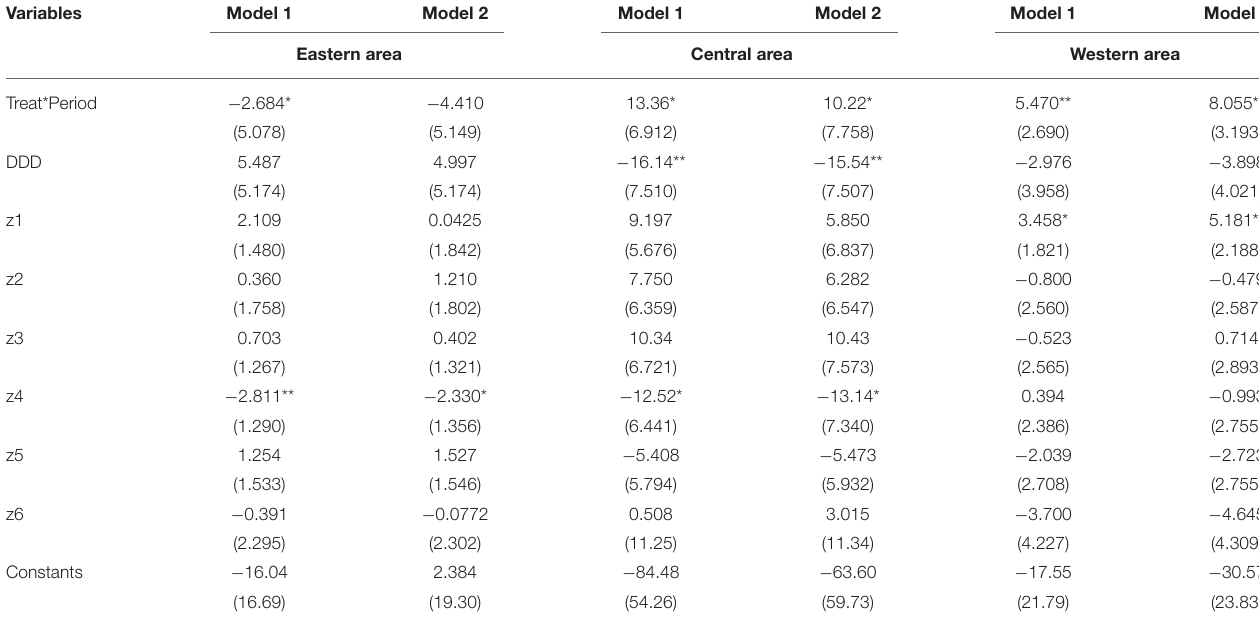
TABLE 9 | DDD regression results at the regional